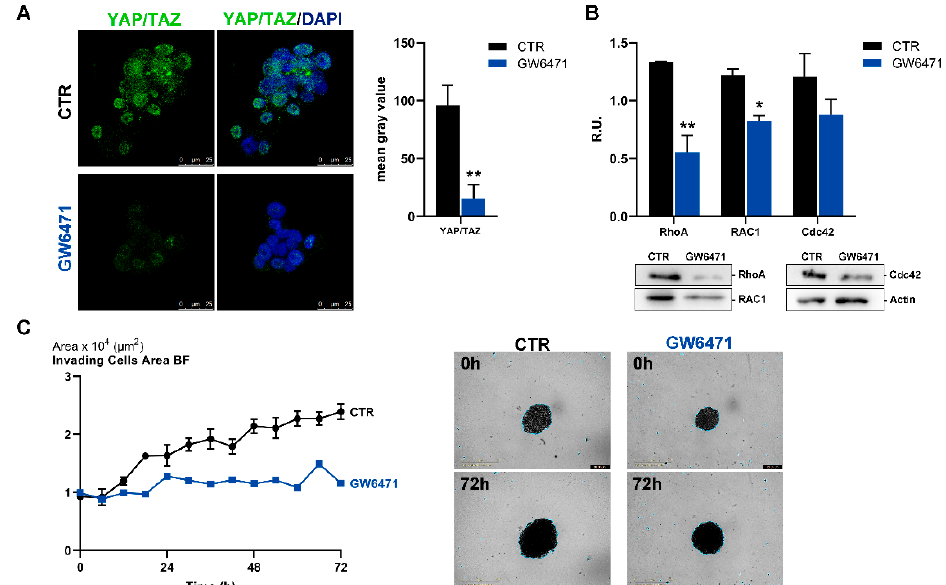
Figure 7. ( A ) Immunofluorescence representative images for the marker YAP/TAZ (in green) in control and treated mammospheres. In blue, the nuclei are stained with DAPI. The graph shows the fluorescence intensity of YAP/TAZ in CTR and treated breast cancer stem cells (CSCs) . Scale bar: 25 µ m. ** p < 0.005 vs CTR. ( B ) Western blotting for RhoA, RAC1, Cdc42 in control and treated mammospheres. A representative Western blot image is shown. ** p < 0.005; * p < 0.05 vs. CTR ( n = 3). ( C ) Live-cell IncuCyte invading assay for control and treated mammospheres analyzed for 72 h and representative bright-field images. Scale bar: 1 mm. For p values relative to IncuCyte assay please see Supplementary Table S1.